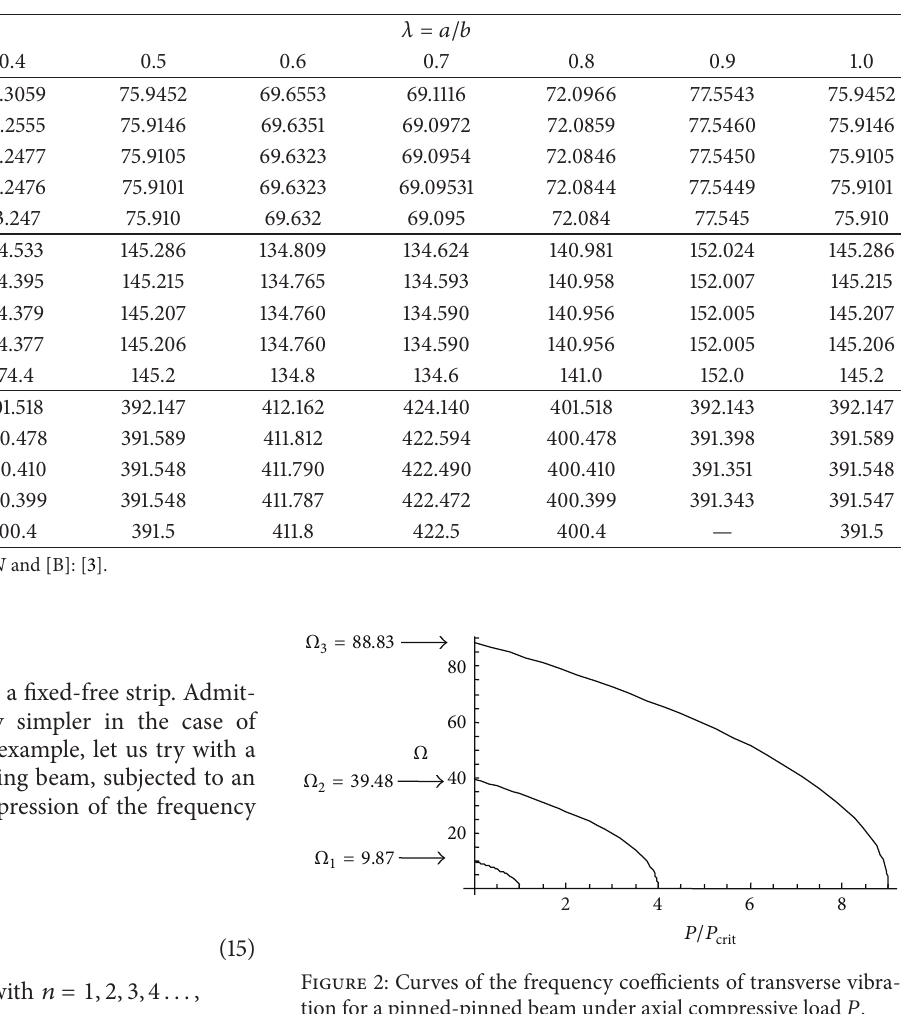
Table 4: Comparison of nondimensional critical buckling loads 𝑁